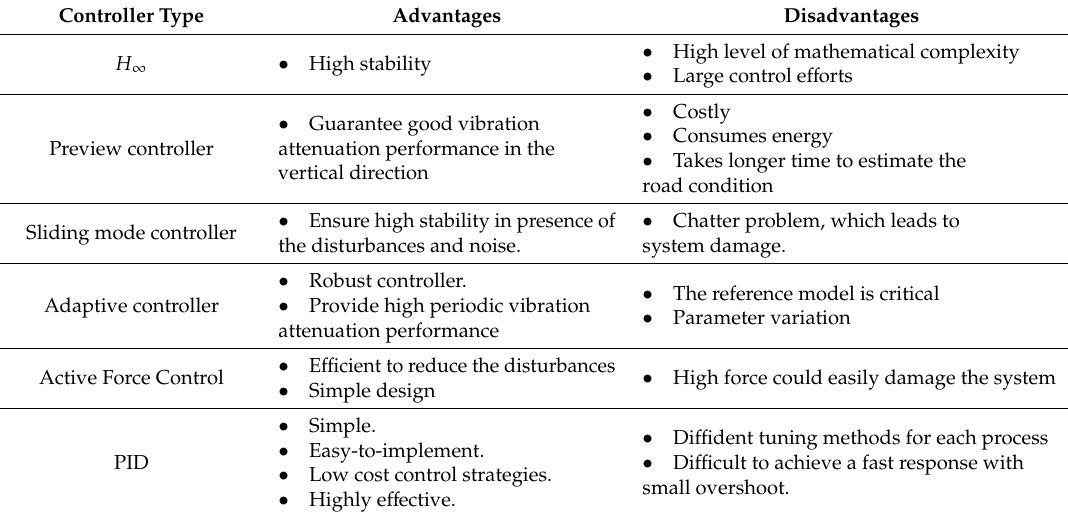
Table 4. Comparison of cons and pros of the control types used in the active seat